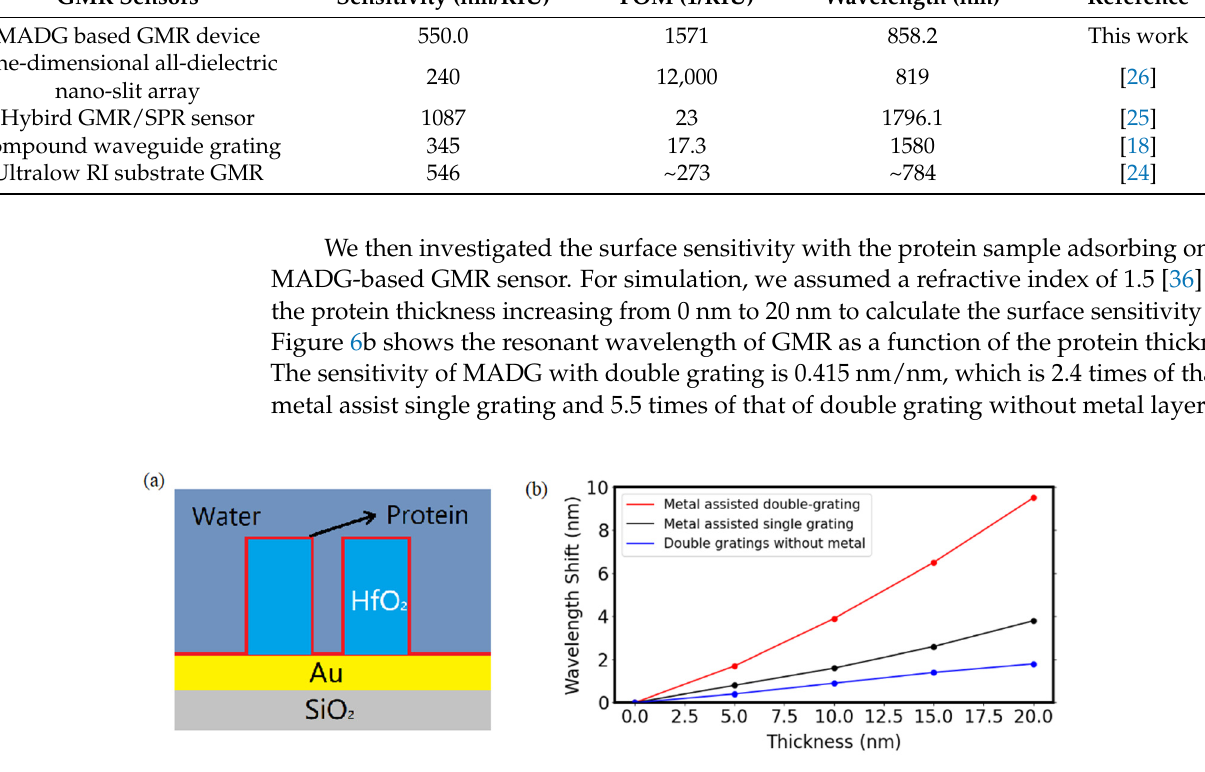
Figure 6. ( a ) Protein adsorption on the MADG-based GMR sensor. ( b ) The shift of resonant wavelength as a function of the protein thickness on GMR sensor. Λ was set at 640 nm, H g at 380 nm, H m at 100 nm, f at 0.25, and f i at 0.2.